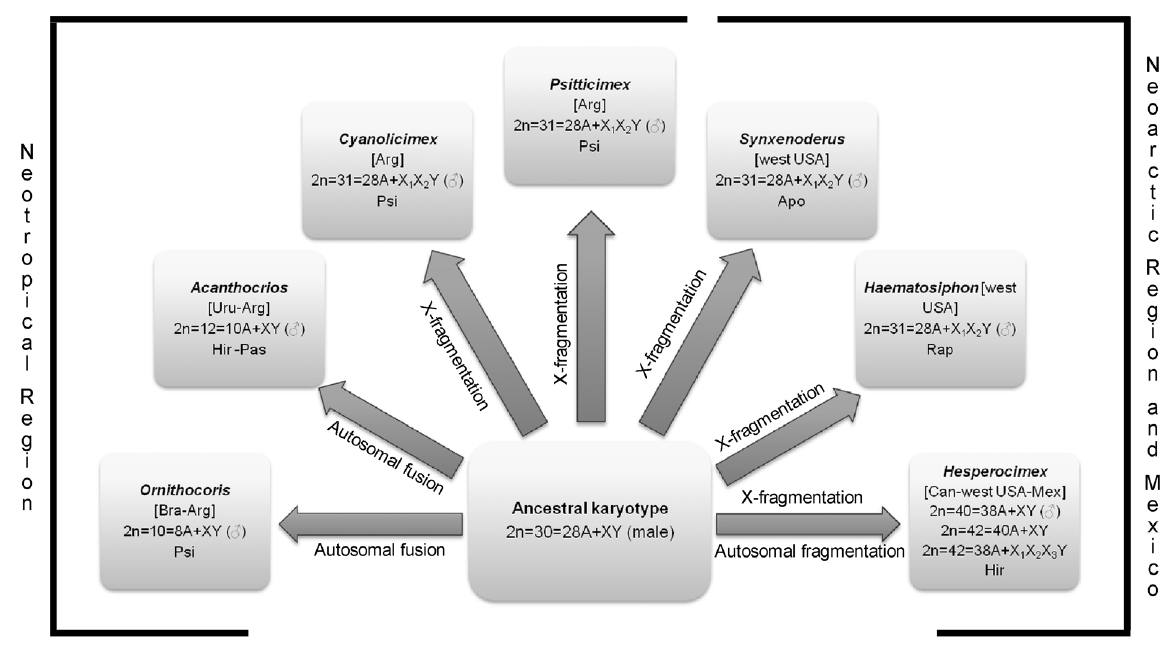
Figure 5. Schematic interpretation of karyotype evolution hypothesis proposed to species of Haematosiphoninae. Avian hosts are Apo, Apodidae; Hir, Hirundinidae; Pas, Passeriformes (Icteridae, Passeridae, Thraupidae, Troglodytidae); Psi, Psittacidae; and Rap, raptorial birds (Accipitridae, Cathartidae, Falconidae, Strigidae, Tytonidae). Bra, Brazil; Arg, Argentina; Uru, Uruguay; Can, Canada; Mex, Mexico; USA, United States of